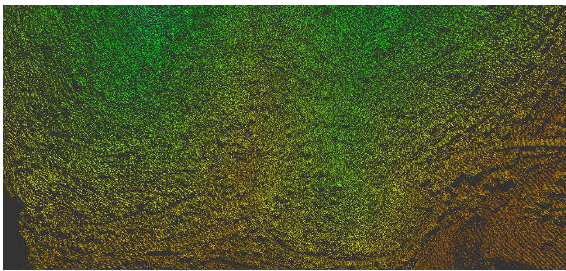
Figure 7: Detail of the large size data set used in the experiment.